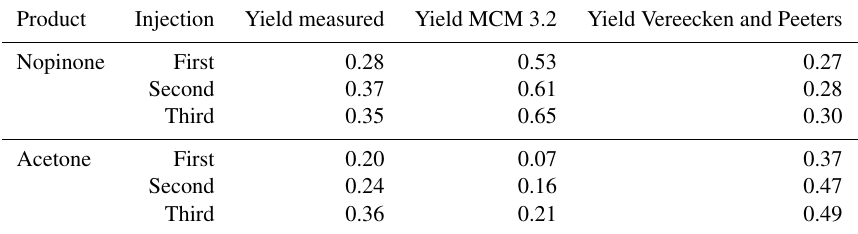
Table 4. Comparison of measured and modeled product yields from the reaction of β -pinene with OH radicals for the three β -pinene injections during the experiment on 27 August 2012. Product Injection Yield measured Yield MCM